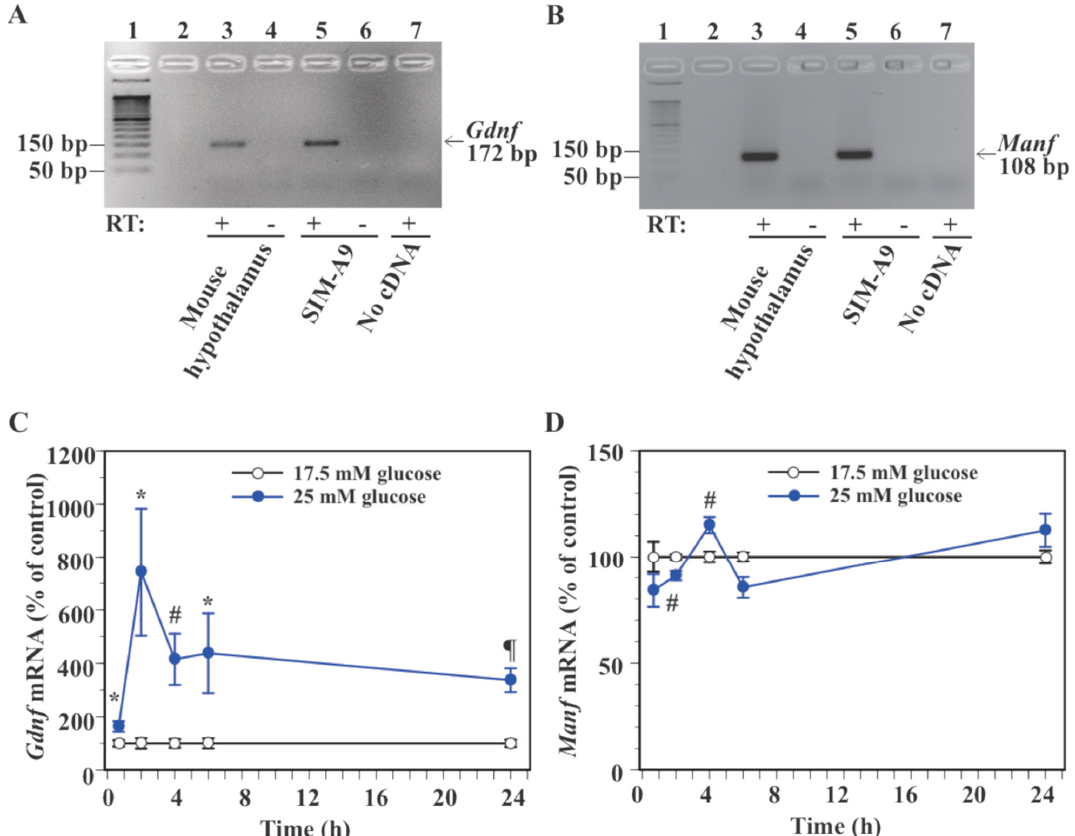
Figure 2. Effect of glucose on the expression of Gdnf and Manf mRNA in microglial SIM-A9 cells. ( A , B ): RT-PCR confirmed the expression of Gdnf and Manf mRNA in SIM-A9 cells. PCR products (172 bp for Gdnf and 108 bp for Manf ) were analyzed by gel electrophoresis. Lane 1: 50 bp DNA ladder; lane 2: no sample loaded, lane 3, 4: mouse hypothalamus; lane 5, 6: SIM-A9 cells; lane 7: no RNA/cDNA. RT: Reverse transcriptase. ( C , D ): Cells were incubated in a culture medium containing 17.5 mM or 25 mM glucose for 40 min, 2, 4, 6, or 24 h. Levels of Gdnf ( C ) and Manf ( D ) mRNA were measured by real-time PCR. Values in the control group (17.5 mM glucose) were set to 100% at each time point ( C , D ). Data are means ± S.E.M. ( n = 7–13/group). *: p < 0.05, #: p < 0.005, ¶: p < 0.001